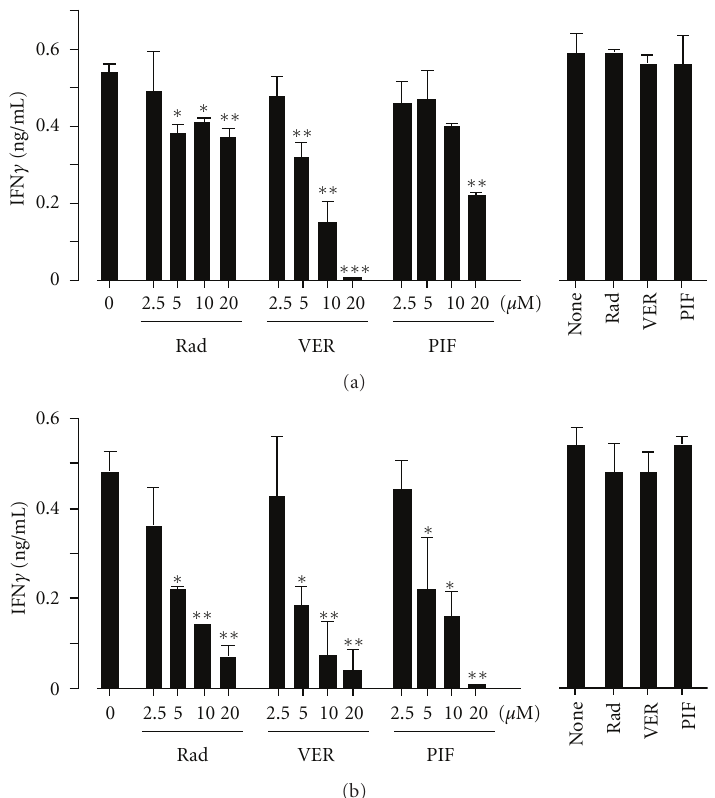
Figure 5: HSP70 inhibitor blocks both endogenous- and cross-presentation. (a) DC2.4cells were transfected with a plasmid containing cDNA encoding OVA by electroporation and immediately incubated with the indicated inhibitors. Three hours later, the cells were fixed and incubated with OTI-CD8 + T cells for 24 hours (left panels). Also, DC2.4cells transfected with an empty plasmid were pulsed with a suboptimal dose of OVA (257 − 264) peptide (10 − 9 M) for three hours in the presence of inhibitors (20 μ M each), fixed and were used as positive controls in the same assay (right panel). (b) DC2.4cells were incubated with 0.5 mg/mL OVA in the presence of the indicated inhibitors for three hours and fixed. The cells were washed and incubated with OTI-CD8 + T cells for 24 hours (left panel). Also, DC2.4 cells were pulsed with 0.5mg/mL OVA in the presence of the indicated inhibitors (20 μ M each) for three hours, fixed and were used as positive controls in the same assay (right panel). The production of secreted IFN γ by T cells in the supernatants was evaluated by ELISA. ∗ P < 0 . 05; ∗∗ P < 0 . 01; ∗∗∗ P < 0 . 001. The results were confirmed in at least two independent